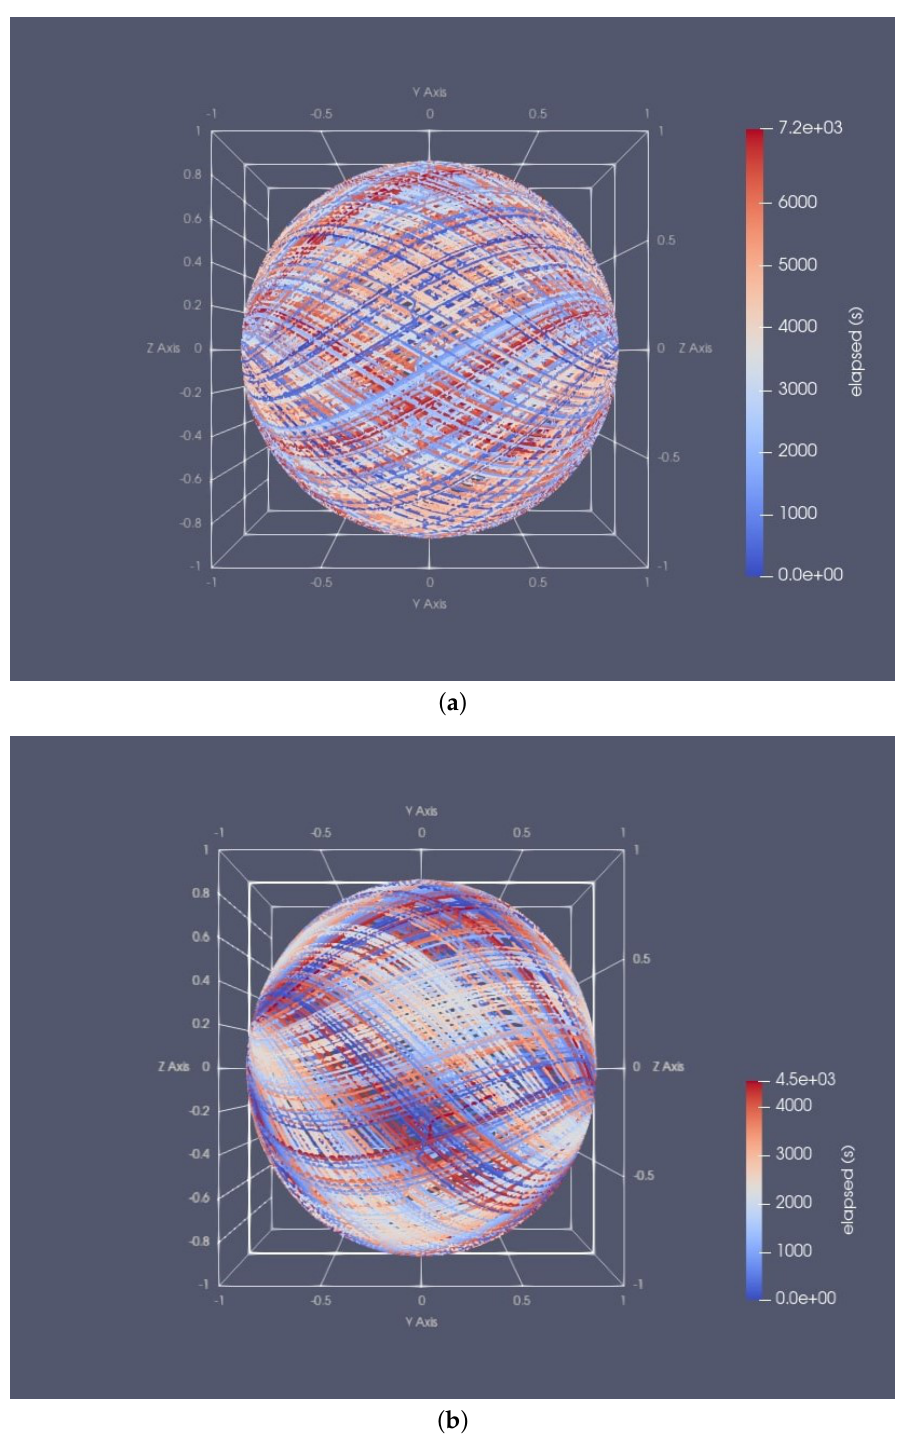
Figure A3. Motion trajectory of the gravity vector tip with ω φ = 0.157 [rads/s] and ω ϕ = 0.262 [rads/s] ( a ) at a distance of 3.5 cm from the center and ( b ) at a distance of 0